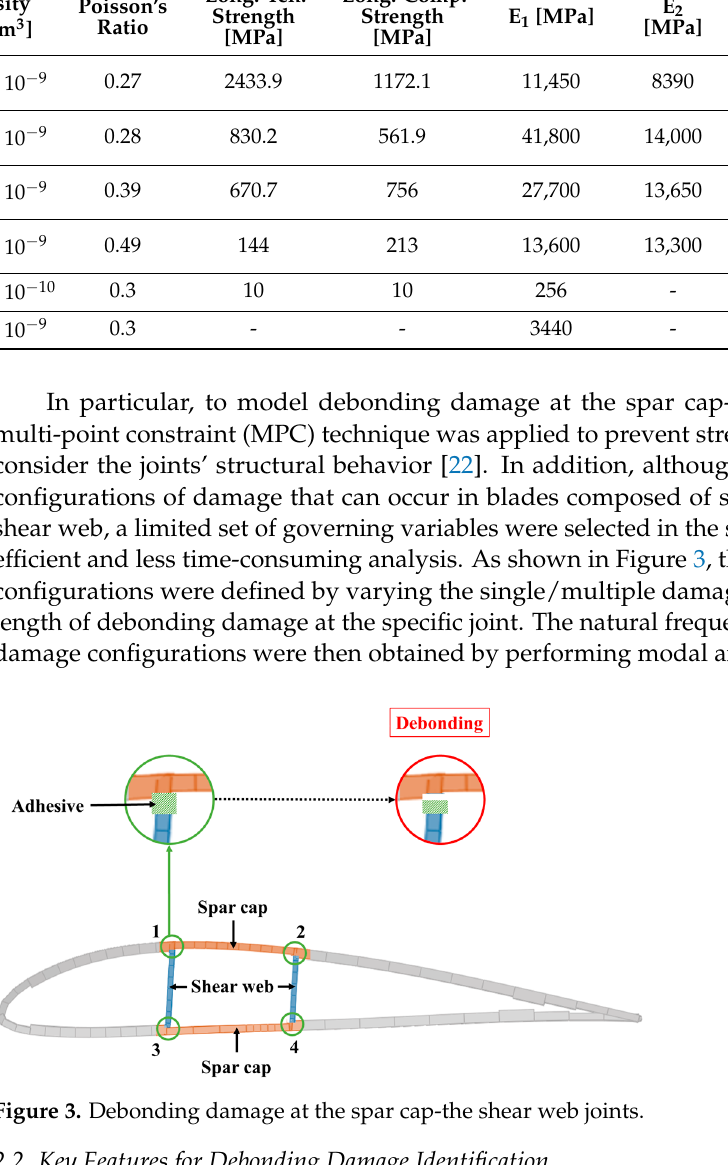
Figure 2. Composite wind turbine blade model. Table 1. Mechanical properties.